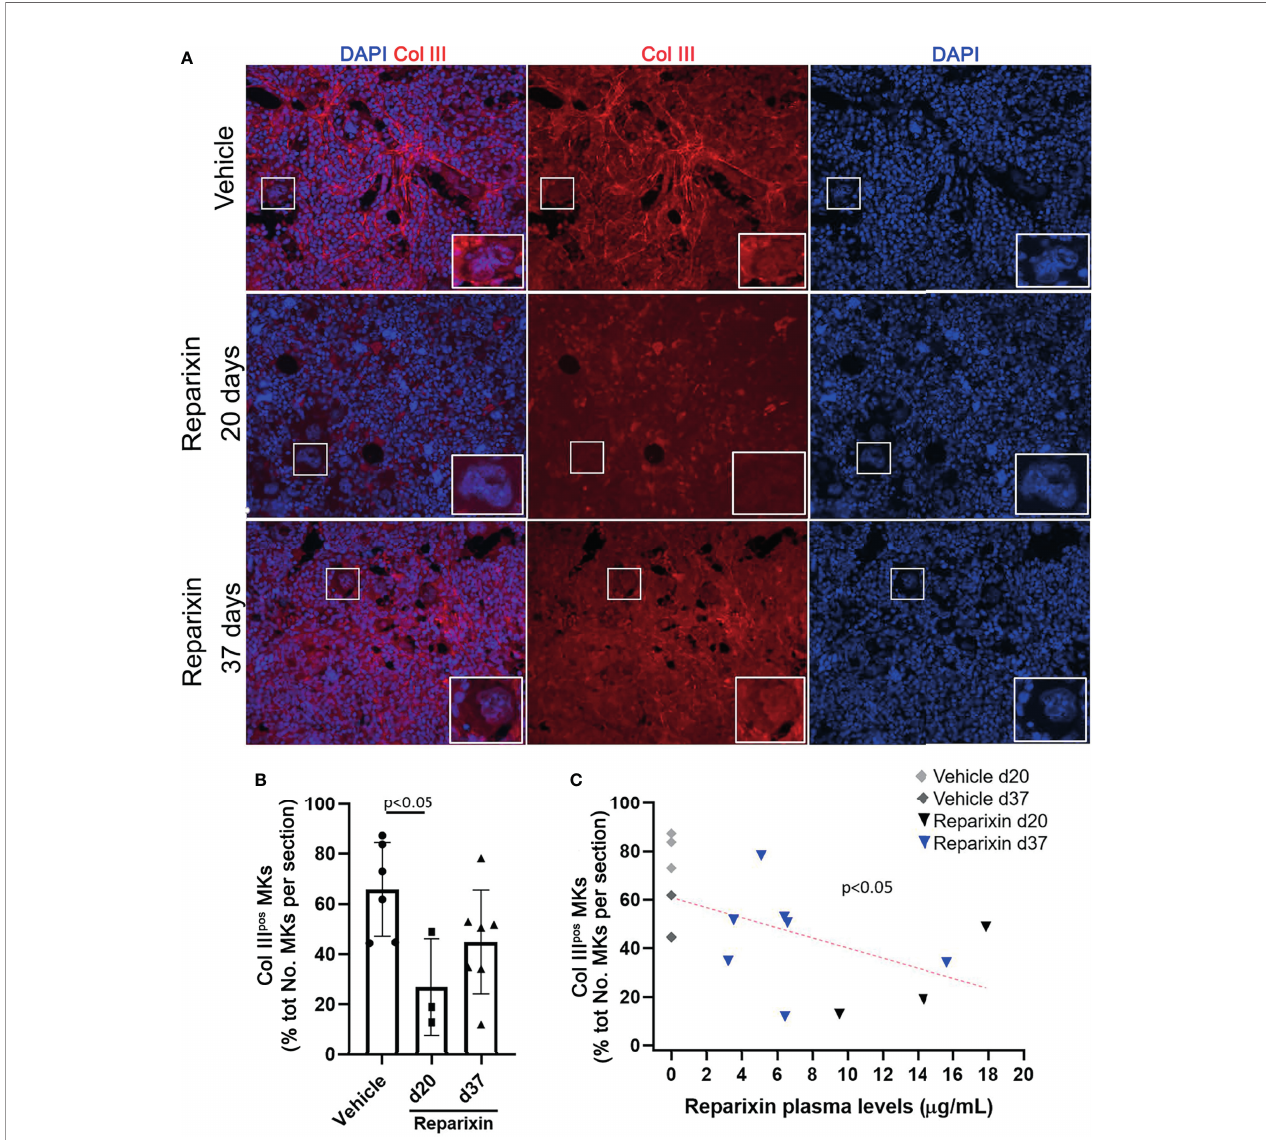
FIGURE 9 | Reparixin reduces in a concentration-dependent fashion the frequency of Col III pos MKs in the bone marrow of Gata1 low mice. (A) Immuno fl uorescence analyses with an anti-Col III (TRITCH-red) antibody of BM sections from representative Gata1 low mice treated either with vehicle or with Reparixin for 20 or 37 days, as indicated. Megakaryocytes were recognized by morphology. Magni fi cation ×400. The white rectangles indicate representative MKs shown at greater magni fi cation on the bottom right of each panel. (B) Frequency of MKs positive for Col III over the total number of MKs per sections quanti fi ed by computer image analyses. Data are presented as Mean (± SD) and as values per single mouse (each dot a mouse) and were analyzed by Tukey ’ s test multiple comparisons test. P < 0.05 was considered statistically signi fi cant. (C) Linear regression analyses between the frequency of CollIII pos MKs and plasma levels of Reparixin in individual mice (Pearson R = − 0.53, p < 0.05). Each dot represents a single